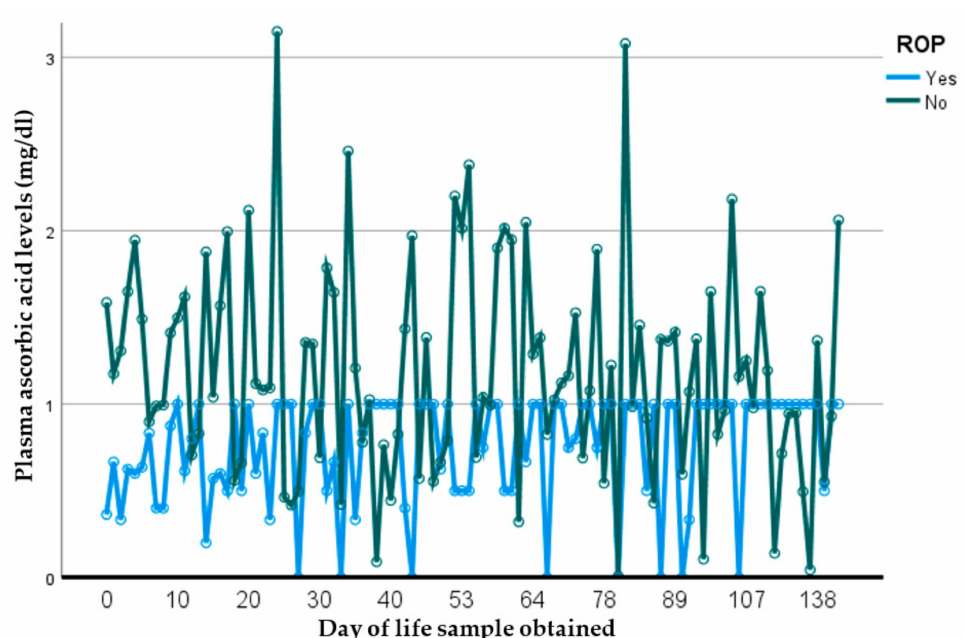
Figure 2. Measured plasma ascorbic-acid levels (mg/dL) per day of life in preterm infants ≤ 34 weeks with and without ROP. Infants who developed any ROP had significantly lower pAscA levels at birth and these remained low throughout the study period compared to those who did not develop ROP ( p = 0.029, 95% CI: − 0.43, 2.63). ROP = retinopathy of prematurity, pAscA= plasma ascorbic